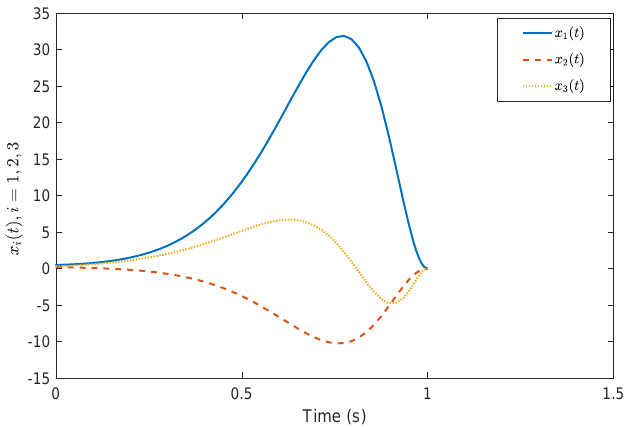
Figure 1. States x (t) by the prescribed-time